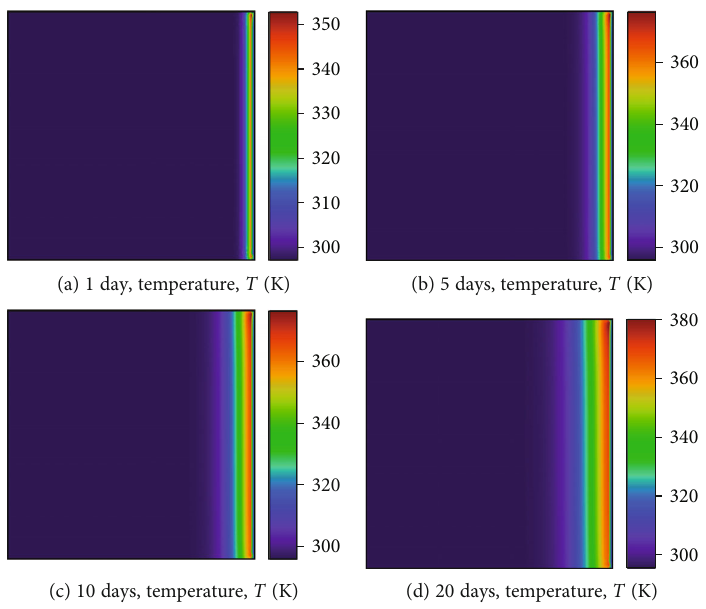
Figure 3: The distributions of the temperature at t = 1 , 5, 10, and 20